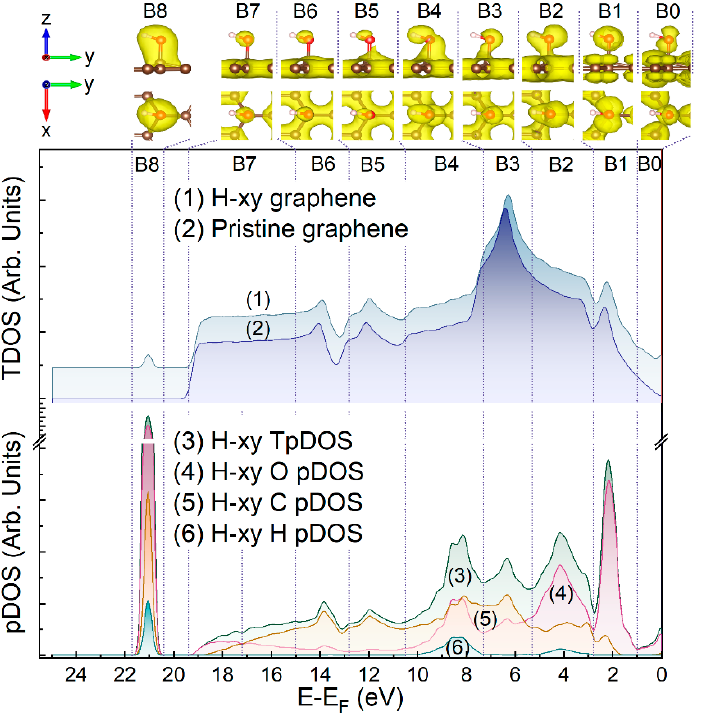
Figure 6. The calculated DOS of the H-xy graphene, pristine graphene layer, C pDOS, O pDOS, H pDOS, and TpDOS, and images of the electron distribution for the hydroxyl group on the graphene layer.